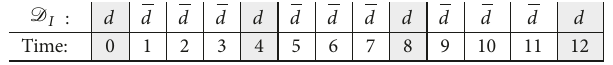
Figure 4: A decision-making process D 𝐼 or collective decision step starting at 𝑡 = 0 composed of debate ( 𝑑 ) and nondebate ( 𝑑 ) substeps. Debate steps are shaded. The number of nondebate steps between debates is 𝑡 𝐷 = 3 ; the number of debates in the decision-making process is 𝑚 = 4